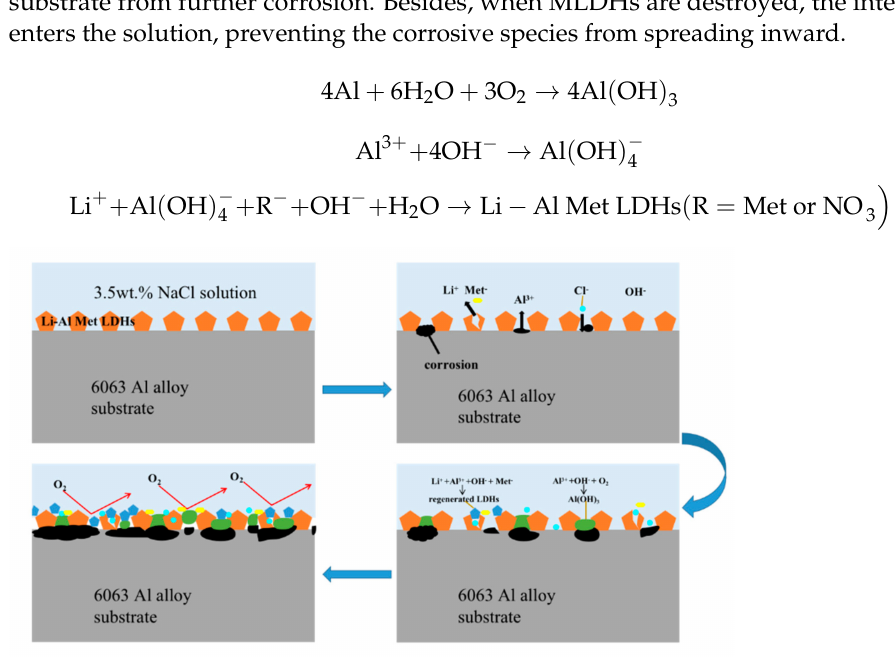
Figure 8. The schematic illustration of the corrosion protection mechanism of MLDHs film on 6063 Al